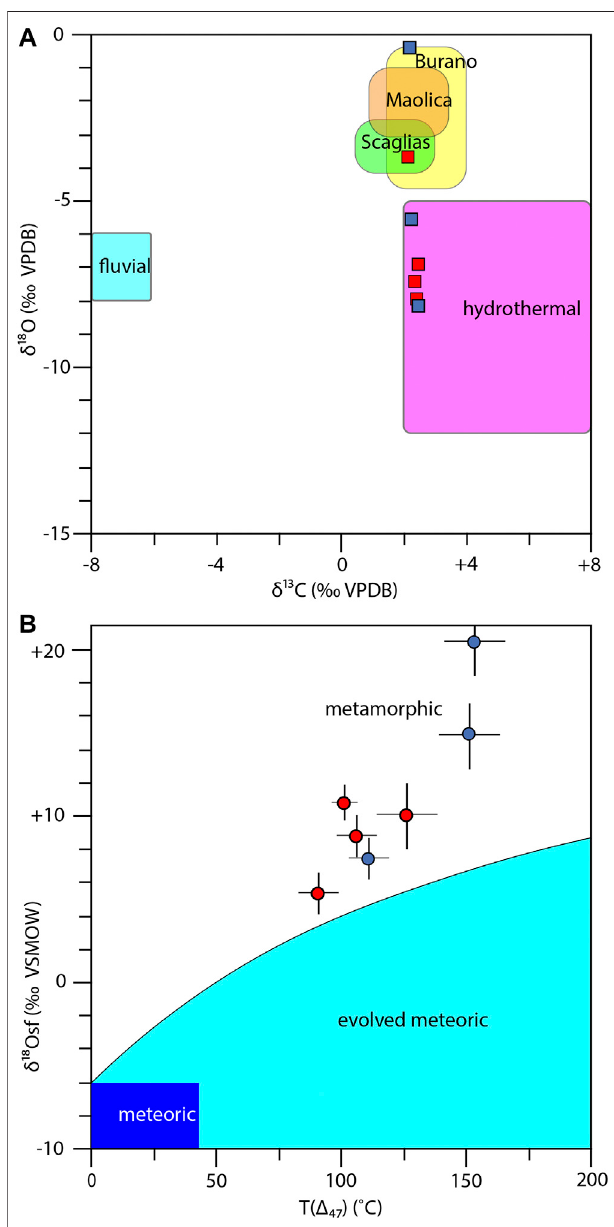
FIGURE 4 | Bulk isotopic composition (A) and carbonate clumped isotope temperatures (T [ Δ 47]) versus calculated fl uid composition ( δ 18Osf) (B) of sampled carbonates and regional sources. Colors indicate corresponding twin type (Type I and Type II; red, Type III; blue). The Scaglias, Maolica, Massiccio, and Burano fi elds are compositions of local marine carbonate (5. Umbria-Marche carbonates, Figure 1A ; e.g., Morettini et al., 2002; Bussolotto et al., 2007) and evaporite (6. Evaporites, Figure 1A ; e.g., Lugli, 2001) host rock formations.